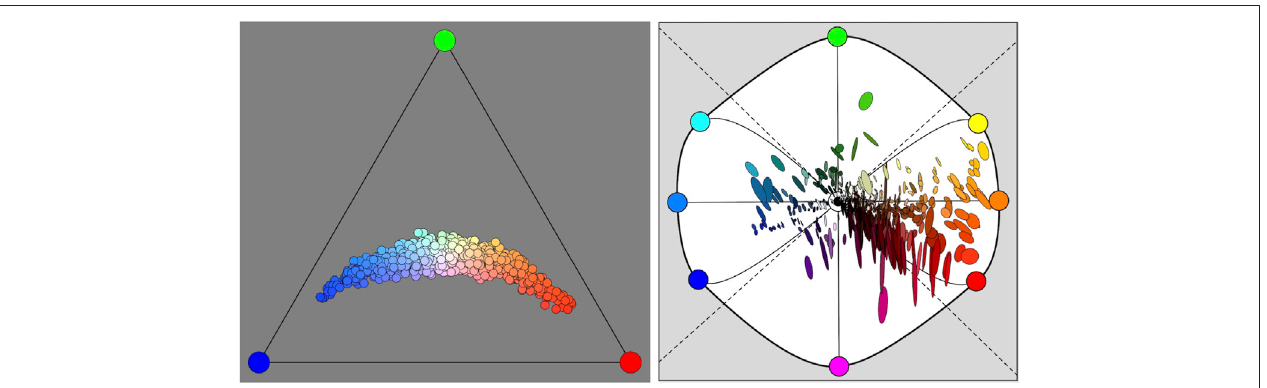
FIGURE 15 | At left a gamut of source colors. Spectral slope and curvature are drawn from mutually independent normal distributions. We plot in the conventional chromaticitydiagram(thoughRGB,nottheCIE-xy)becausethesearebeamcolors.Atright75%confusionellipsesintheorthographicchromaticitydiagram,computed foralargedatabaseofpigments.Mostoftheconfusionis(roughly)inthepurple – green.Becausethere fl ectancespectraarearbitrary,thepatternofellipseshasachaotic pattern. This is a very wide gamut of sources, so the conclusion is that AWB does a good job of correcting for source